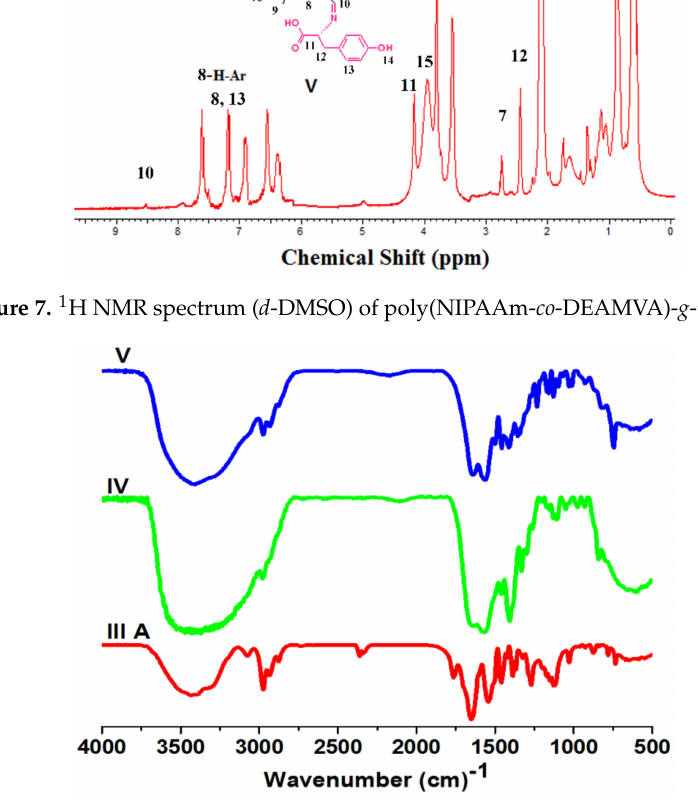
Figure 8. IR spectra and poly(NIPAAm- co -DEAMVA) IIIa–c of grafted copolymers IV–V